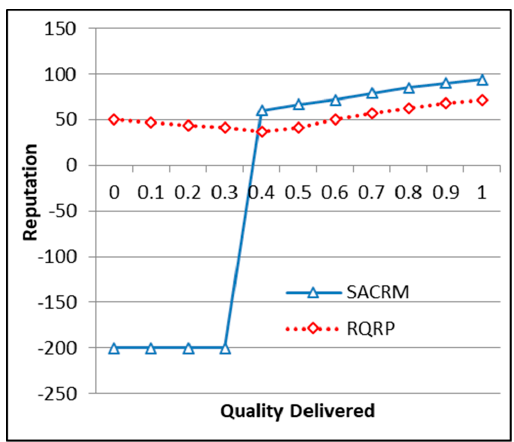
Figure 10. Delivered quality vs. reputation score. SACRM: social aware crowdsourcing with reputation management.